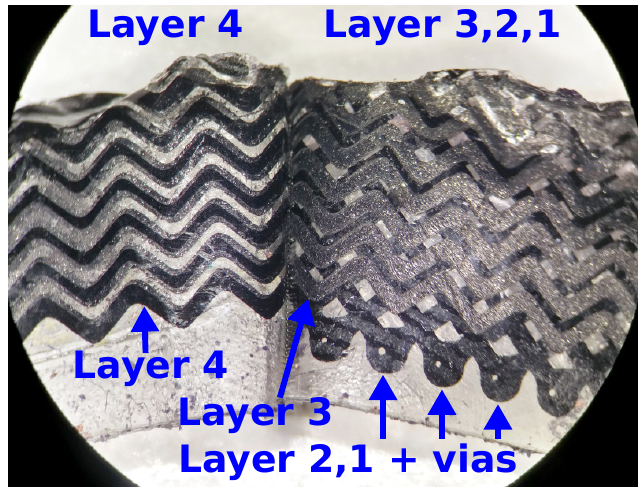
Figure 27: Cut-off piece of the GORE envelope, showing all four layers. The sheets comprising layer 3 and 4 have been partially pulled appart for illustration